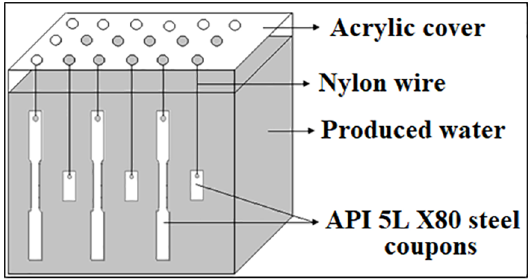
Figure 3. Schematic diagram of the static systems used in the